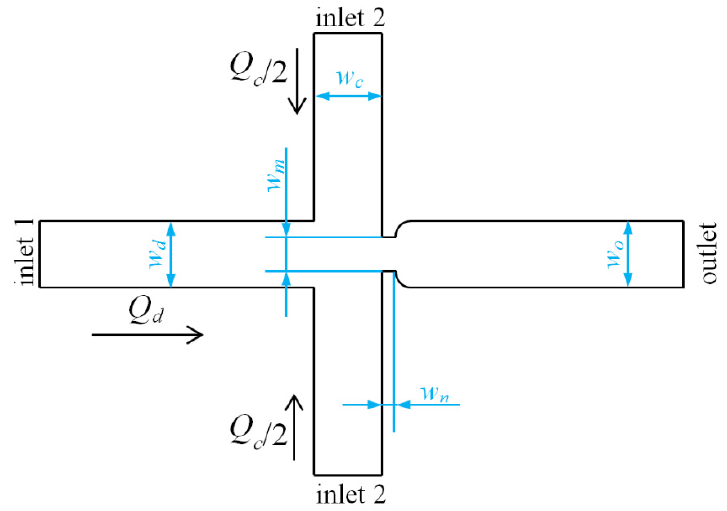
Figure 2. Schematic diagram of the flow-focusing microfluidic chip.